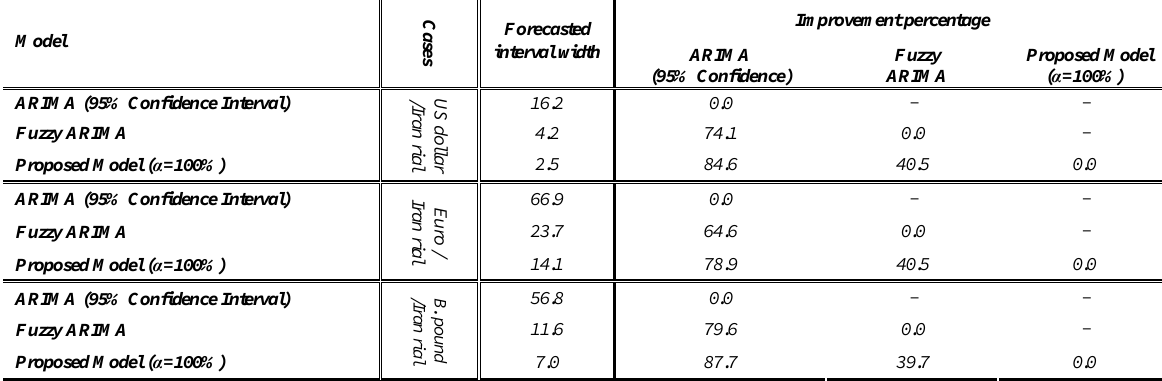
Table 6. Comparison of forecasted interval widths by the proposed model compared to other models (interval estimation).